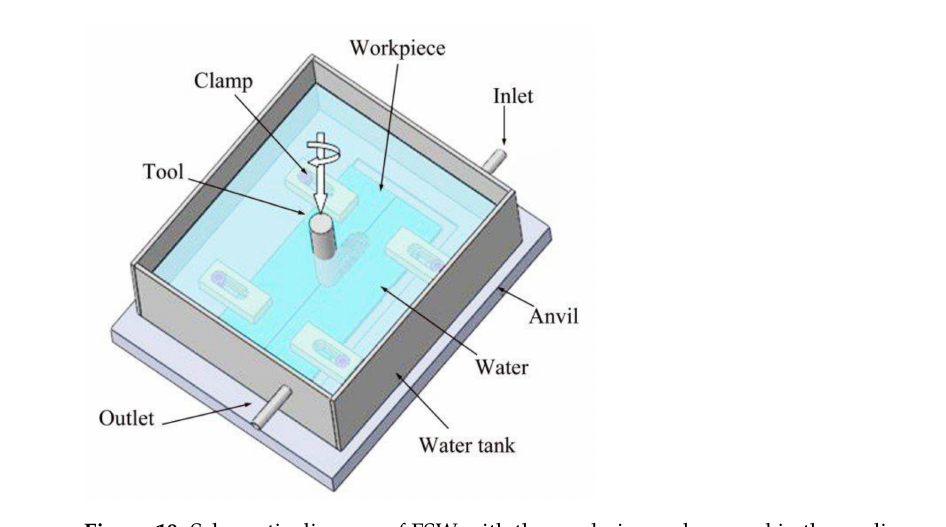
Figure 19. Schematic diagram of FSW with the workpiece submerged in the cooling medium [174]. The cooling medium has a great influence on the mechanical properties of the